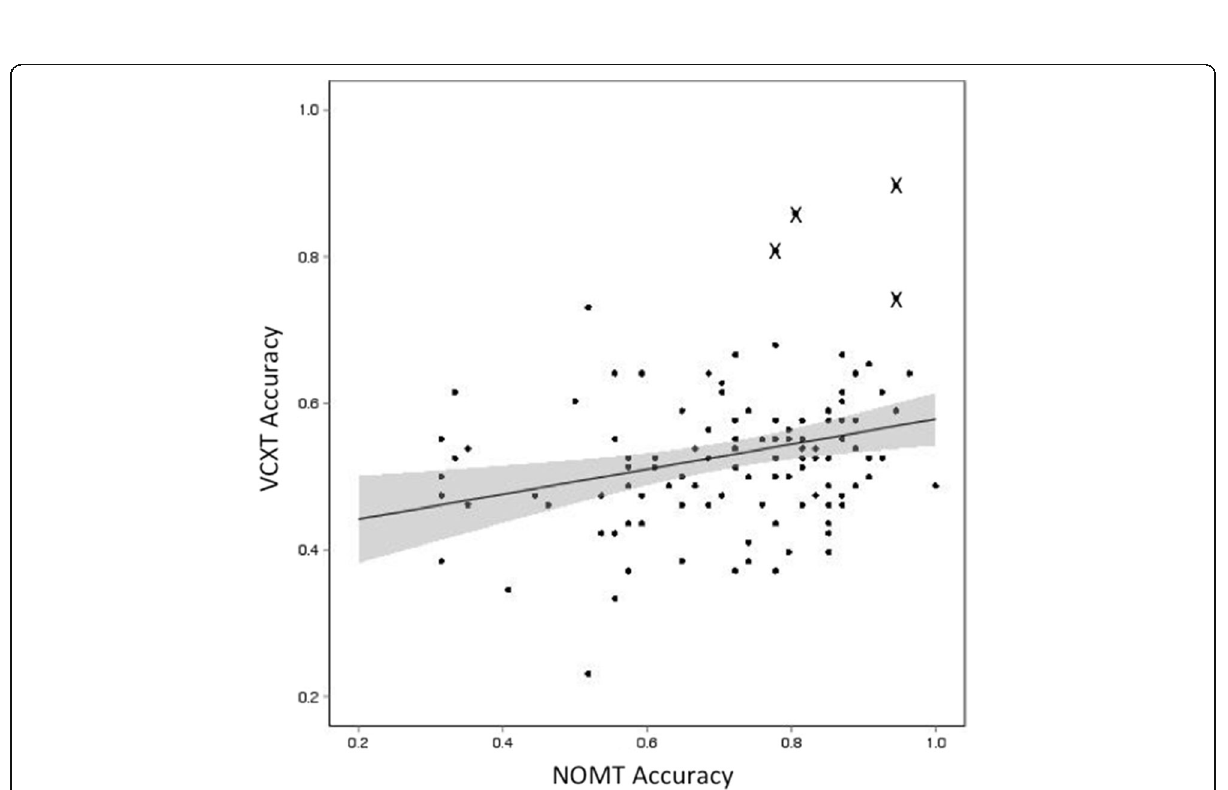
Fig. 3 Scatterplot of Novel Object Memory Test (NOMT) and Vanderbilt Chest Radiograph Test (VCRT) accuracies ( N = 112, medical professionals ’ data points marked with X ’ s). Shaded region indicates 95% confidence intervals